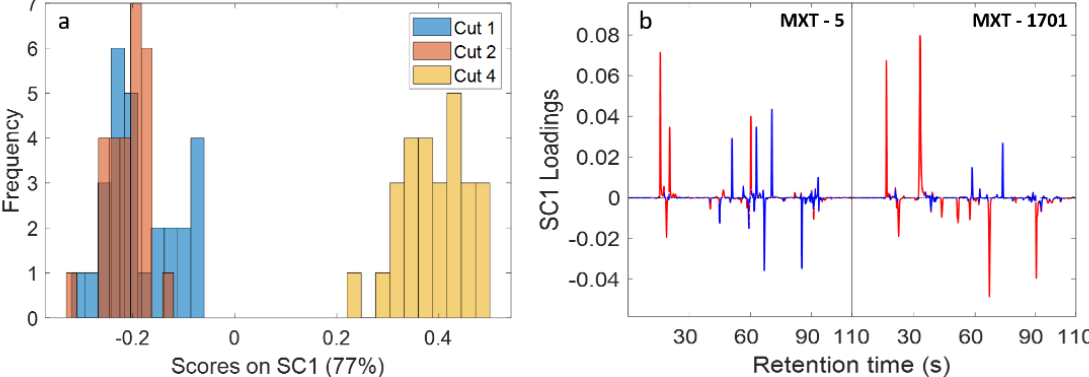
Figure 7. Results of ASCA performed on the 2021 samples. The SCA for the effect of the factor “variety”. ( a ) SC1 vs. SC2 score plot. Empty symbols represent the projected residuals; ( b ) SC1 and ( c ) SC2 loadings plot. In loading plots, red lines indicate statistically significant regions, whereas blue lines indicate regions associated with loadings statistically indistinguishable from zero.